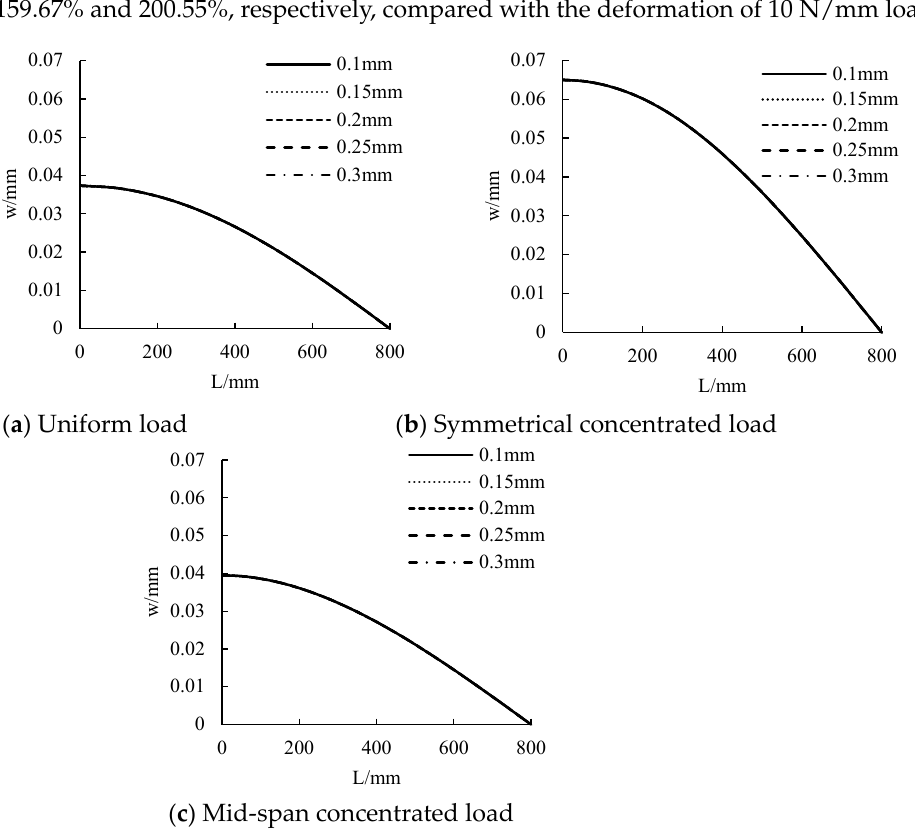
Figure 14. The influence of temperature on displacement.